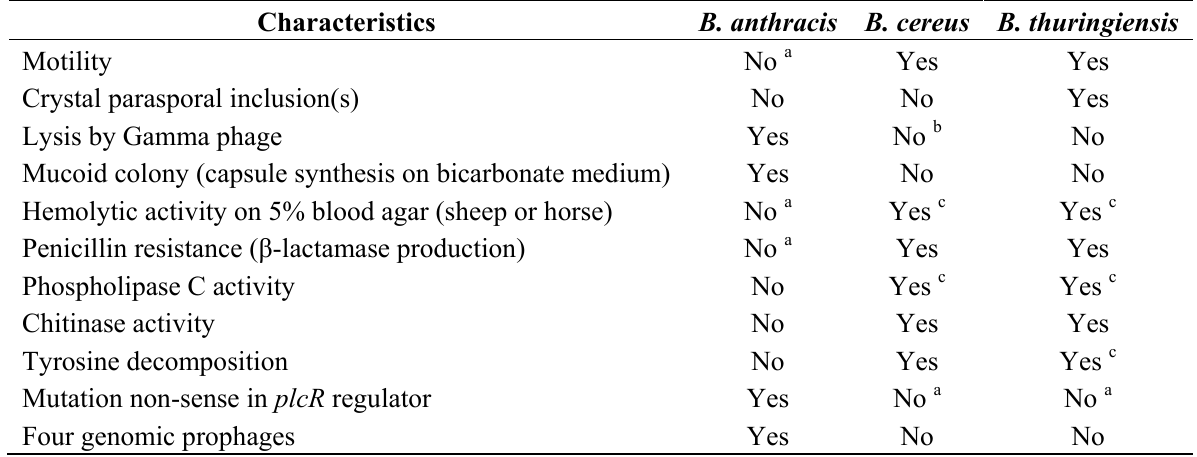
Table 1. Characteristics commonly used to differentiate B. anthracis , B. cereus and B. thuringiensis